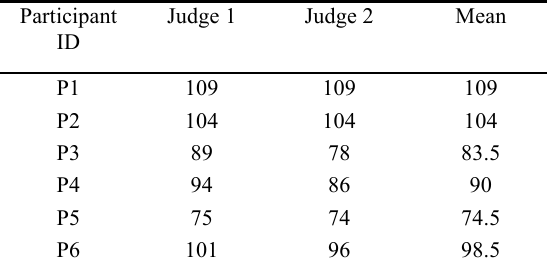
Table 2. Scoring of SR